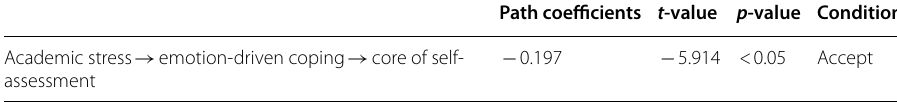
Significant at the level of 0.01 ( p < 0.01) Table 11 Results of the relationship between self-assessment core and academic stress (Sobel test)